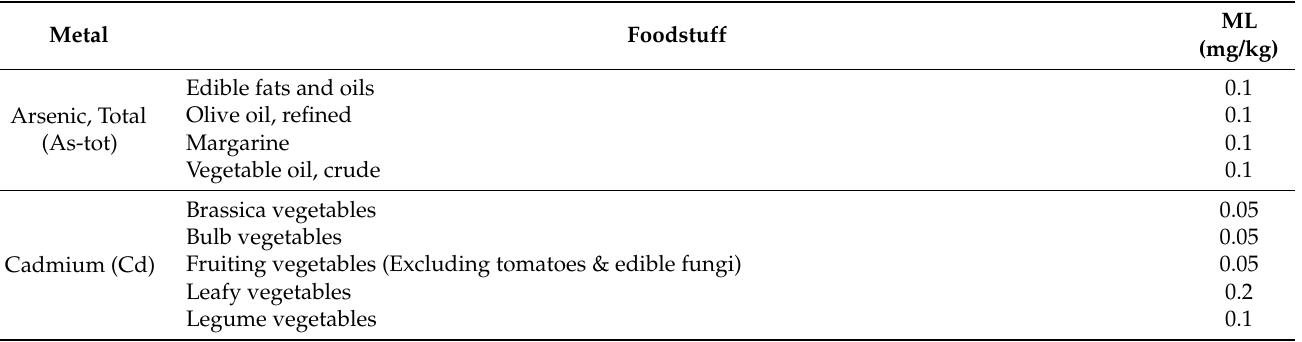
Table 5. Maximum levels of selected metals in foodstuffs as determined by in the Codex Alimentarius International Food Standards